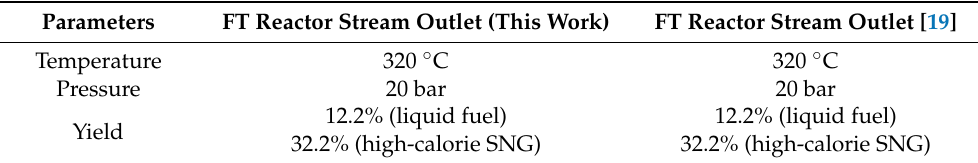
Table 2. Comparison between simulated and the experimental reactor outlet stream for Liquid/high- calorie-SNG fuel synthesis